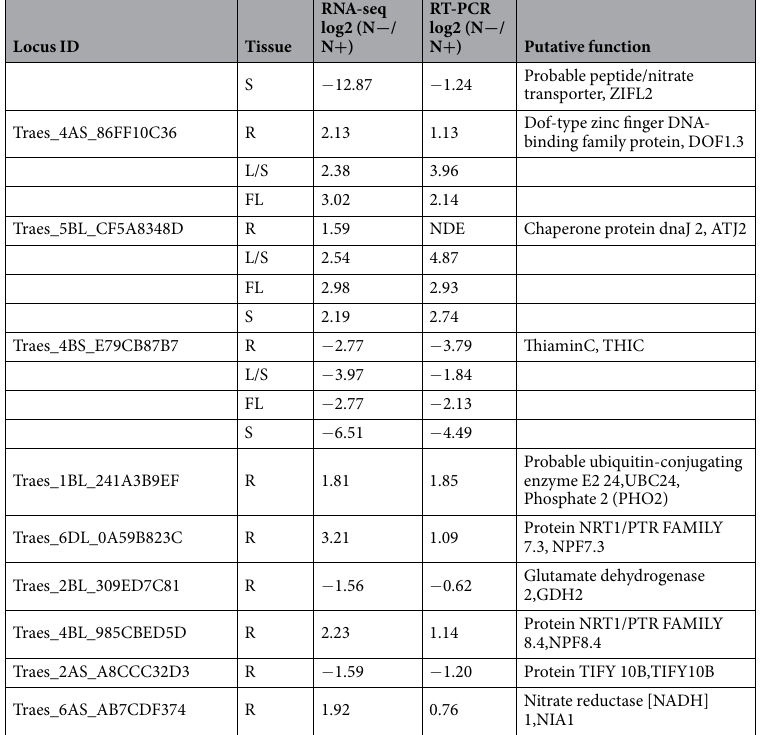
Table 3. RNA-seq results confirmed by quantitative qPCR. R: root, L/S: leaves/stems, FL: flag leaf, S: spike, NDE: Not Differentially